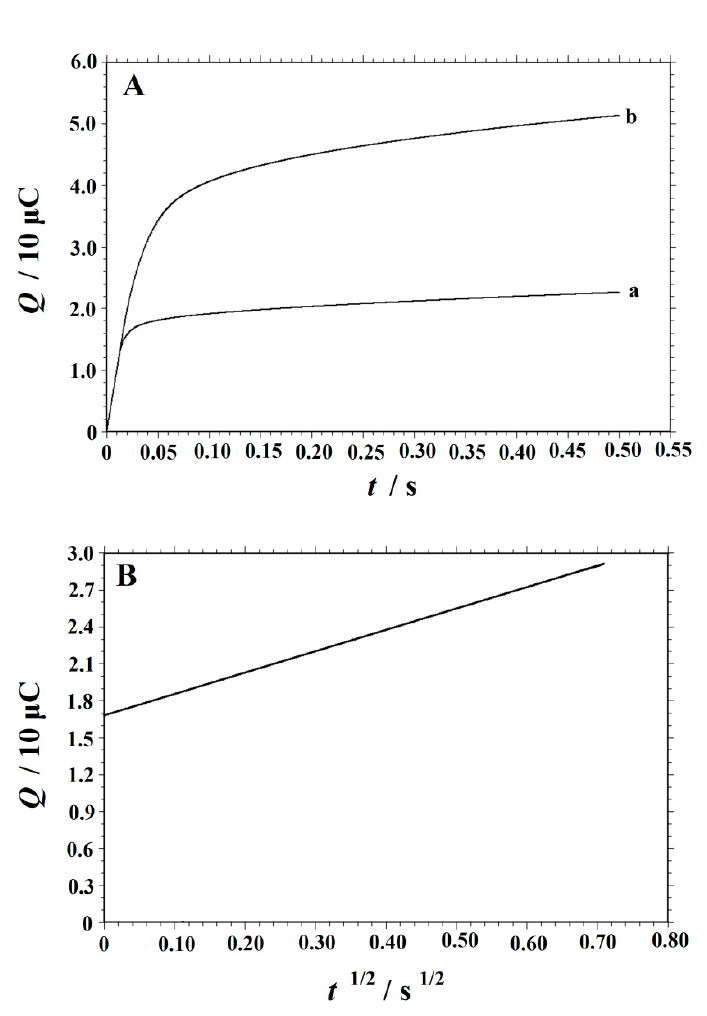
Figure 6. ( A ) Plot of Q – t curve obtained on the CeO 2 / ERGO / GCE in 0.1 M HCl solution in the absence (a) and presence (b) of 0.1 mM vanillin. ( B ) plot of Q – t 1 / 2 curve on the CeO 2 / ERGO / GCE (background subtracted).